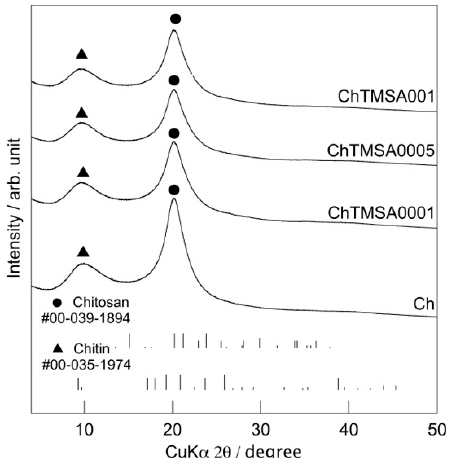
Figure 4. XRD patterns of the chitosan − TMSA microfibers. Table 1. The half width values at 2 θ = 20° from XRD patterns.